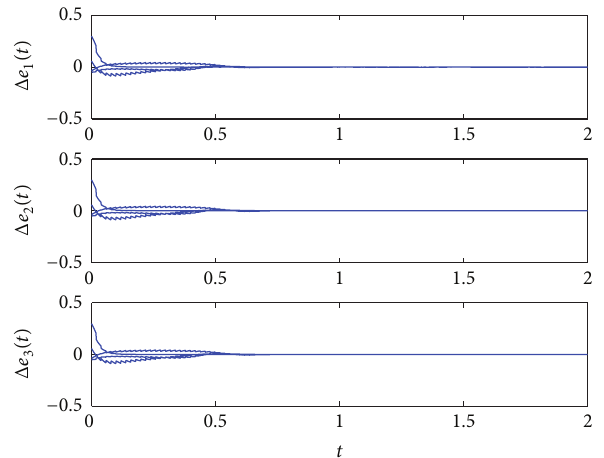
Figure 3: Observer estimated states jumps at the impulse times.